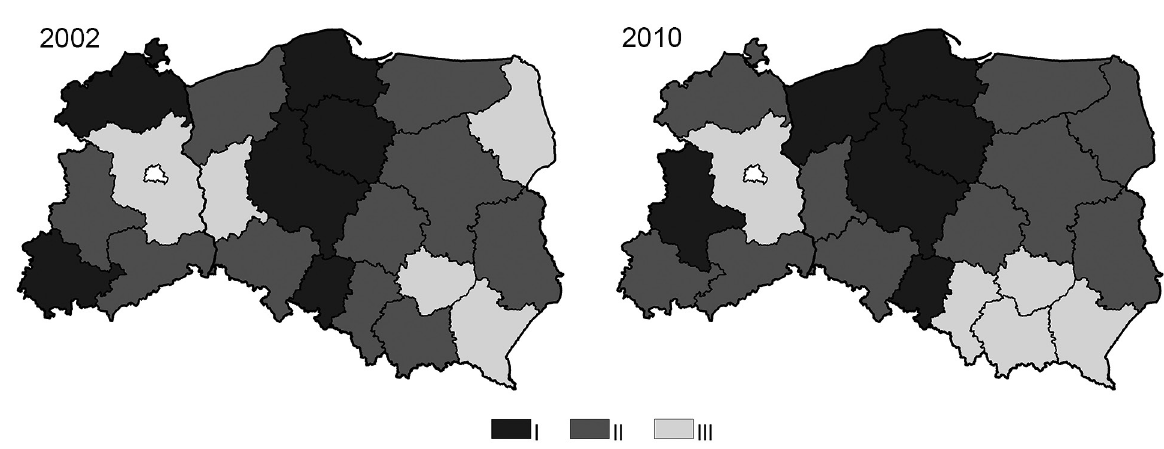
Fig. 8. Types of agricultural development in Poland and East